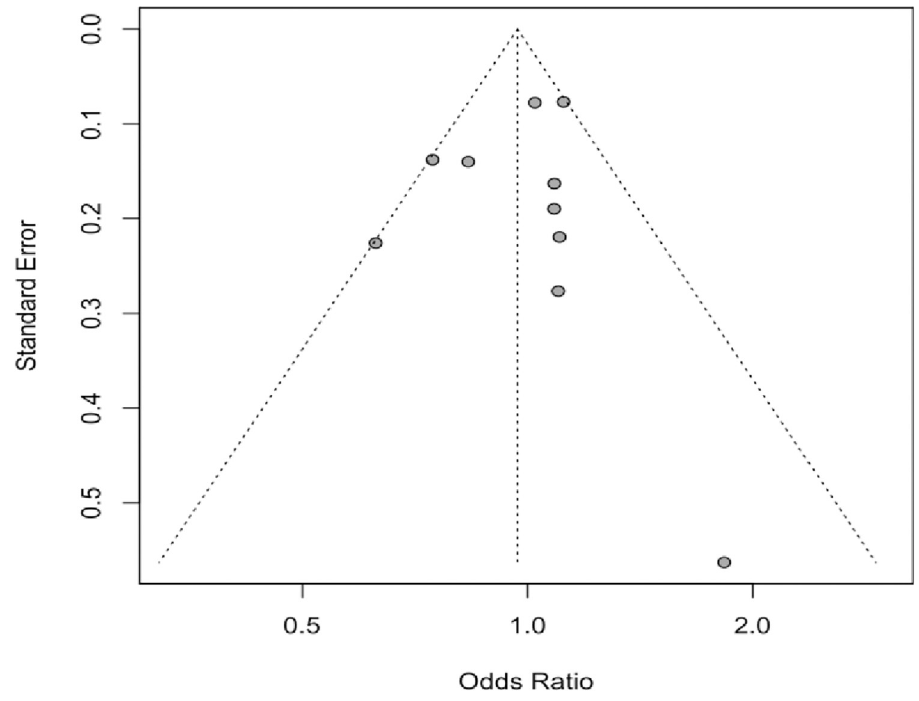
Fig 10. Funnel plot for the Rhesus